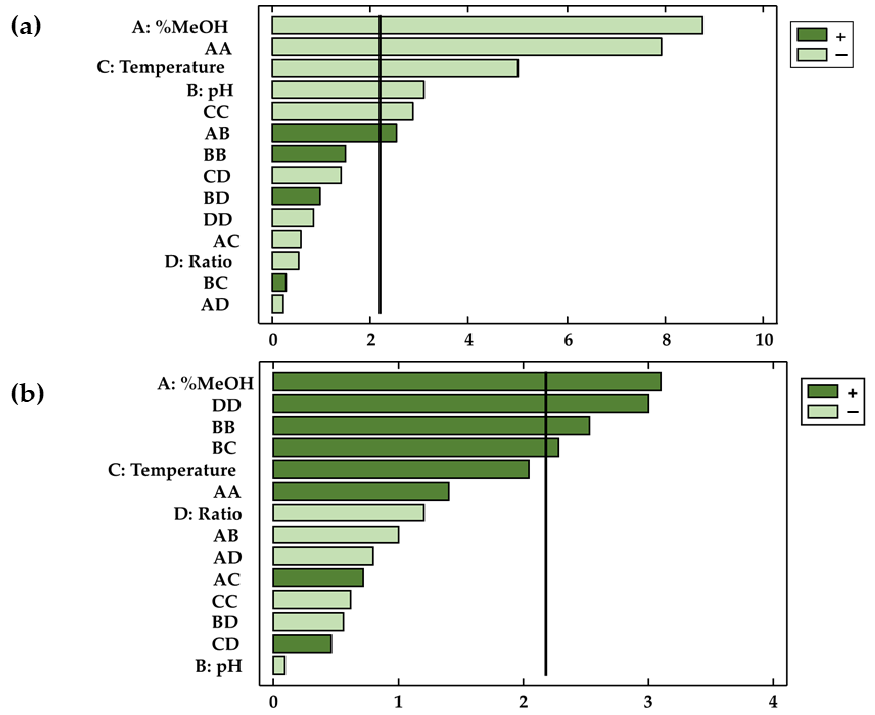
Figure 3. Pareto diagrams for the two responses: ( a ) total anthocyanins and ( b ) total phenolic com-